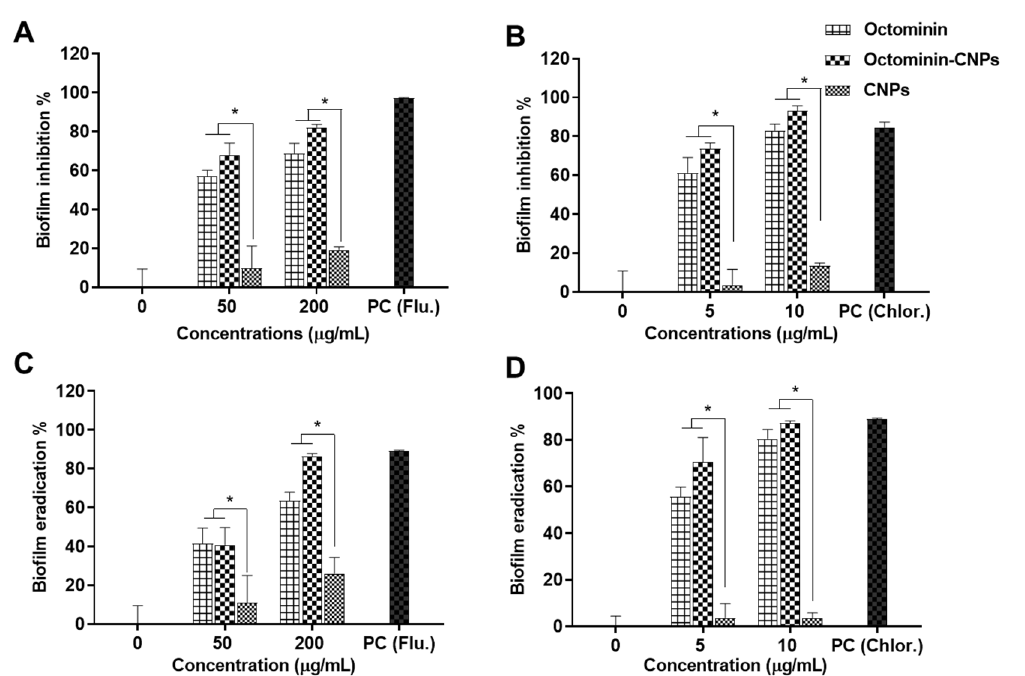
Figure 7. Comparison of antibiofilm activity in C. albicans and A. baumannii upon Octominin-CNPs, Octominin, and CNPs. Biofilm inhibition of ( A ) C. albicans and ( B ) A. baumannii with Octominin-CNPs, Octominin, and CNPs treatments. Biofilm eradication assay on pre-formed biofilms of ( C ) C. albicans and ( D ) A. baumannii upon treatments of Octominin-CNPs, Octominin, and CNPs. Remaining biofilms after incubation were quantified with the crystal violet staining method. * p < 0.05: the error bars indicate the mean ± SD (n = 3).